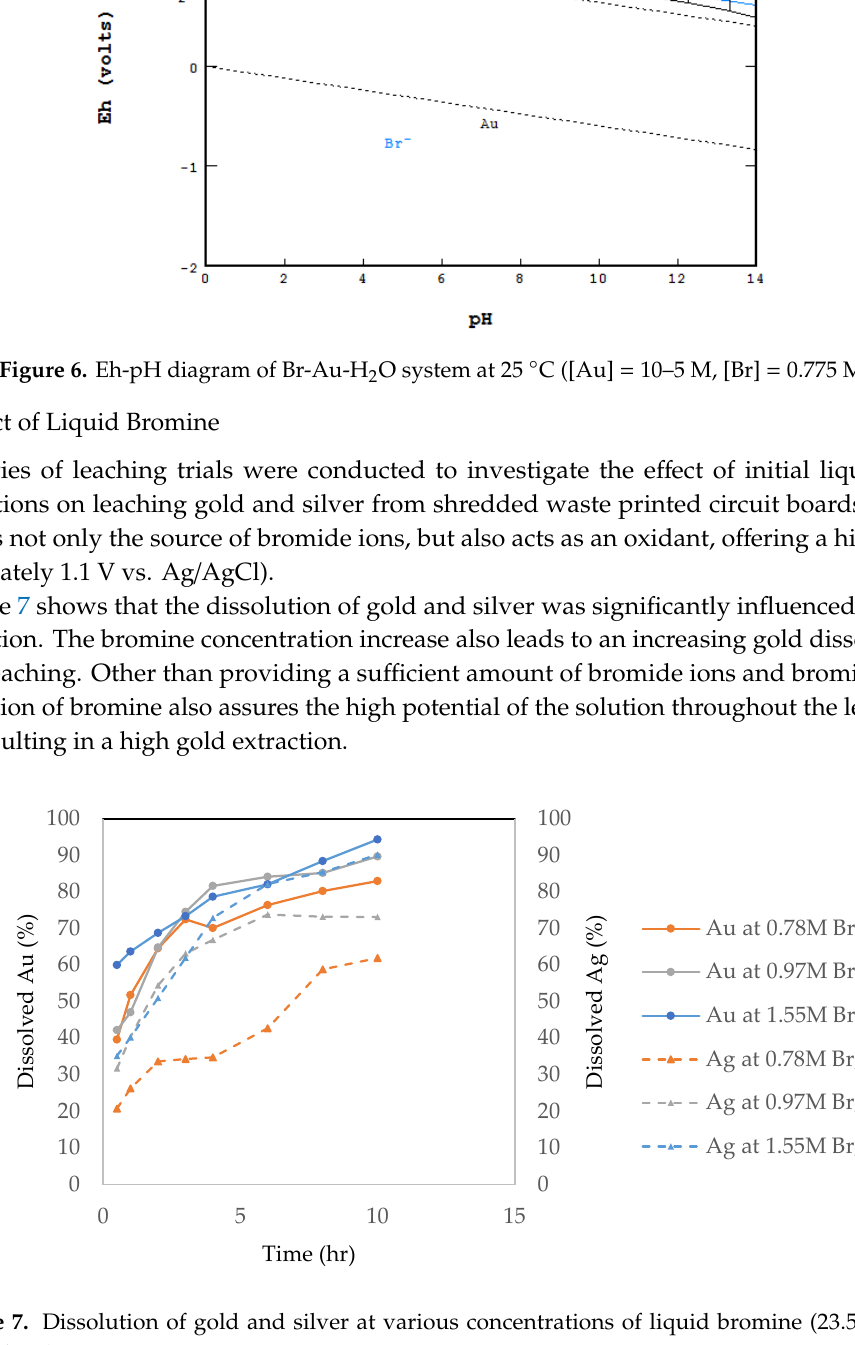
Figure 6. Eh-pH diagram of Br-Au-H 2 O system at 25 °C ([Au] = 10–5 M, [Br] = 0.775 M).